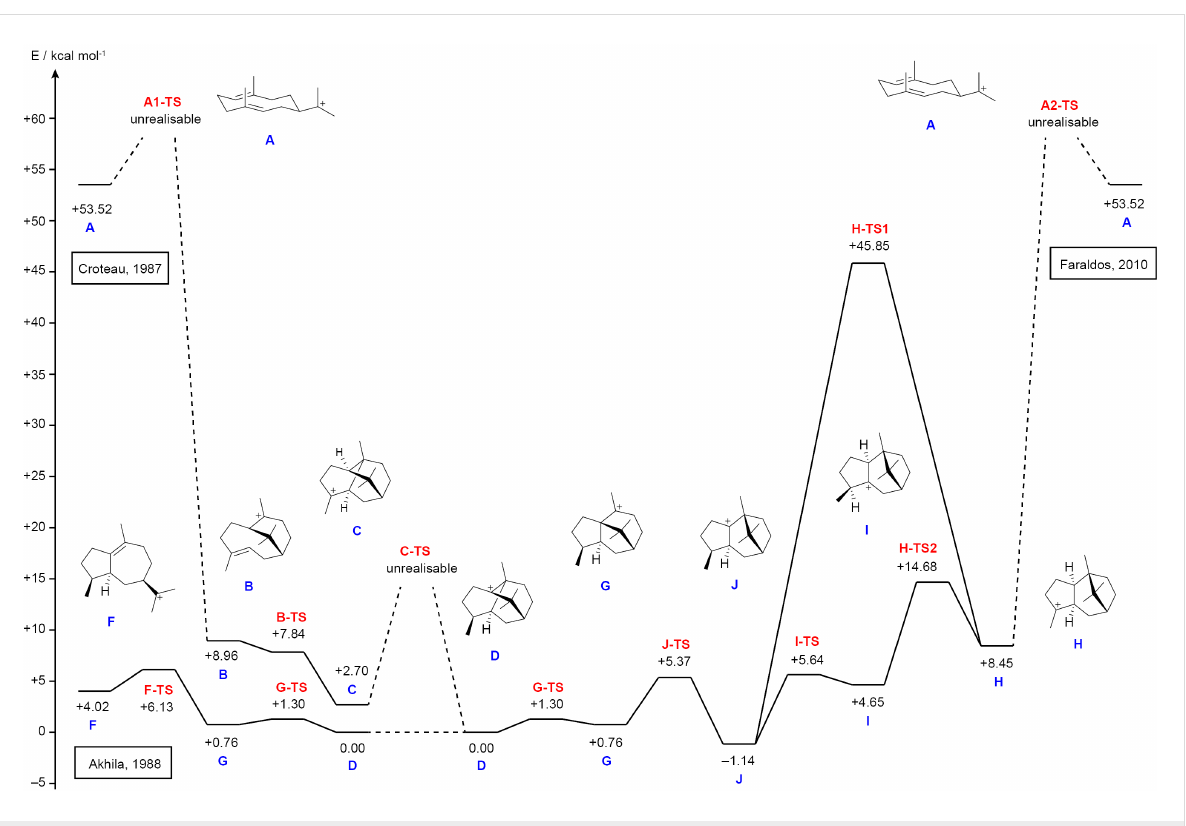
Figure 3: Energy profile from DFT calculations (Gibbs energies at 298 K, mPW1PW91/6-311 + G(d,p)//B97D3/6-31G(d,p)) for the three mechanisms of 3 biosynthesis by Croteau et al. [9], Akhila et al. [10], and Faraldos et al. [14]. The direct precursor of 3 in all three mechanisms, cation D , was set to 0.00